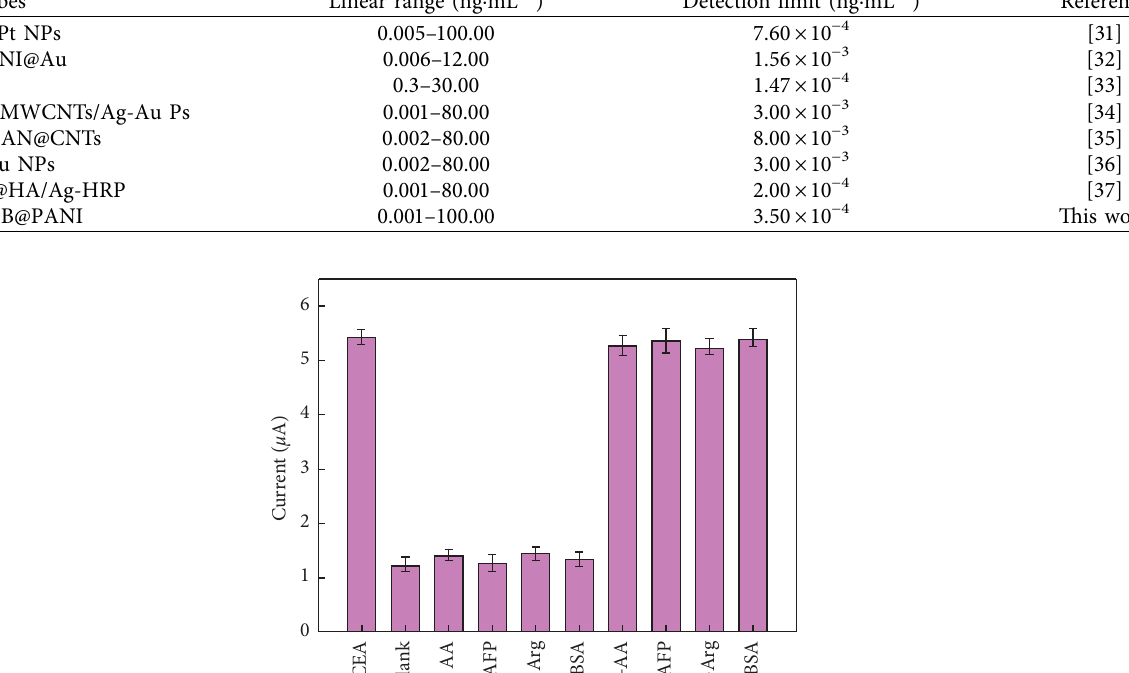
Table 1: Comparison of analytical performance of CEA immunosensors with diferent nanoprobes.